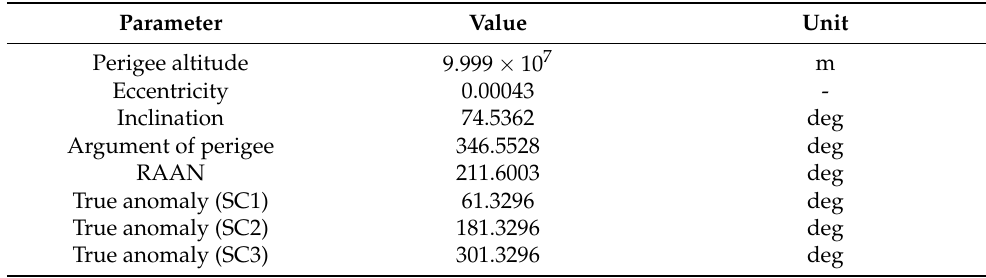
Table 1. Desired orbital parameters.